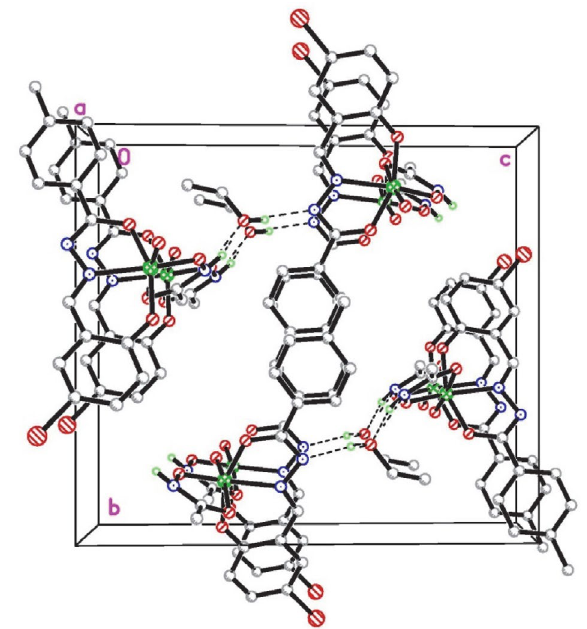
Figure 4. Hydrogen bonds linked structures of complex 2